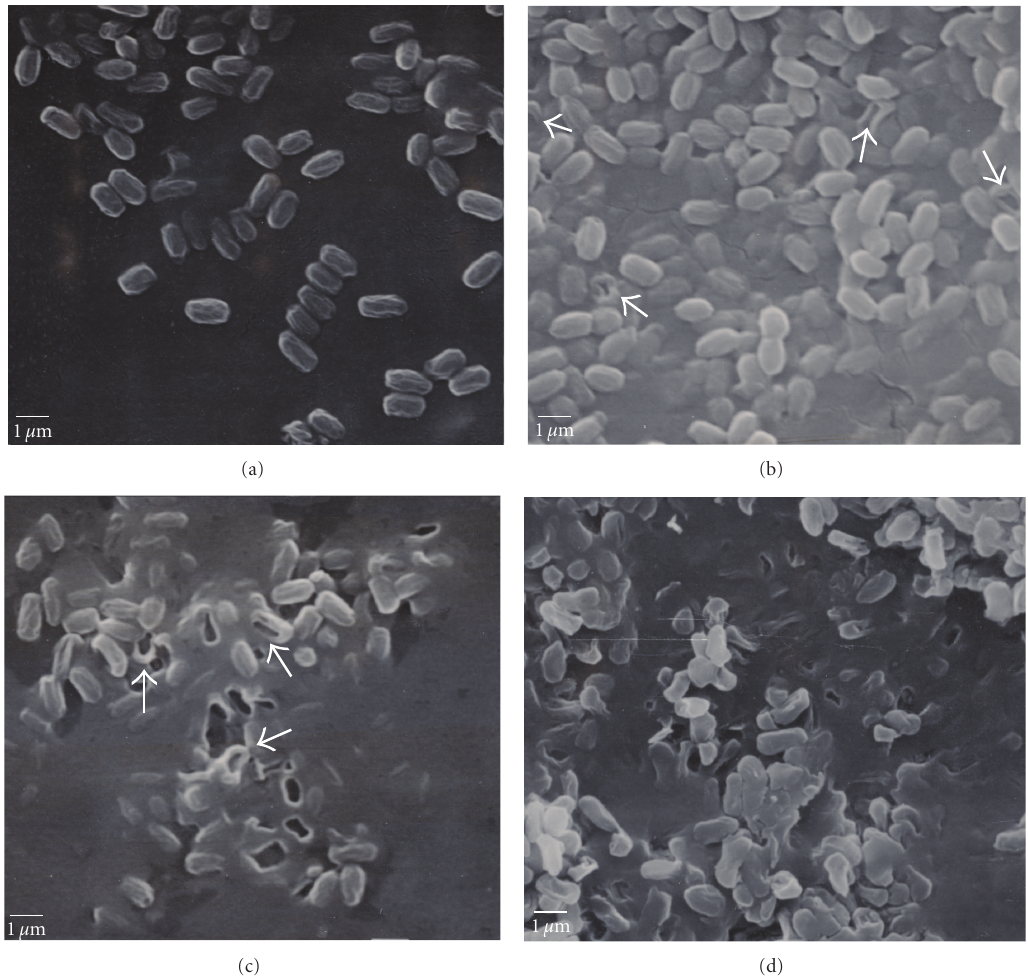
Figure 5: Scanning electron micrographs illustrating spore damage at varying EB dosages: (a) control spores (5,400 x magnification), (b) 5.3kGy (5,400 x), (c) 10.4 kGy (5,400x), and (d) 21.7 kGy (5,400 x). Scale bar is 1.0 µ m. White arrows indicate ruptured